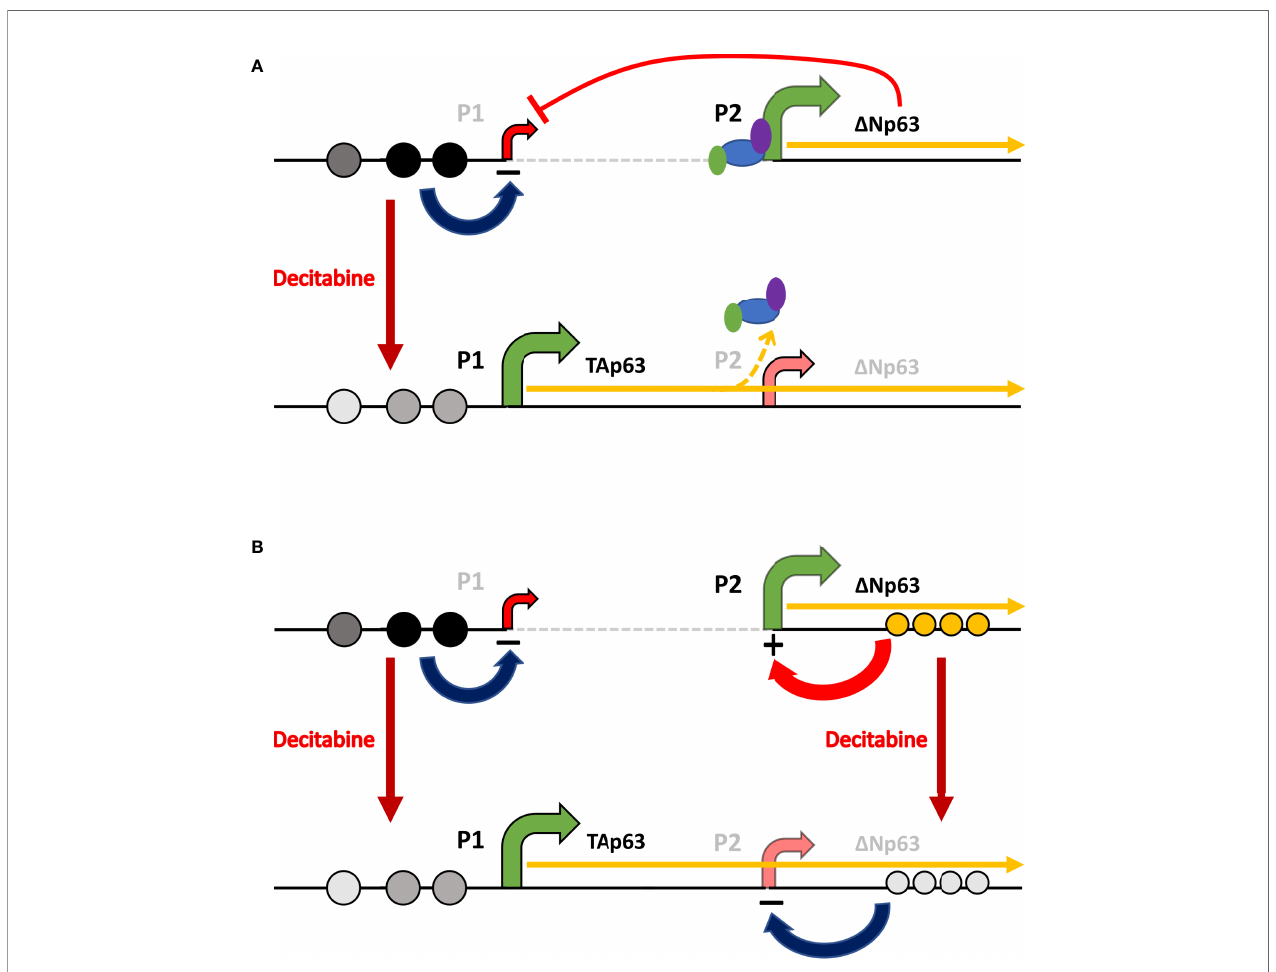
FIGURE 10 | Schematic of the potential mechanisms involved in reciprocal regulation of TAp63 and D Np63. (A) In squamous cells, where D Np63 is highly expressed from the P2 promoter, methylation of CpG sites (dark gray or black circles) at P1 inhibits TAP63 transcription and reduced methylation at these sites after decitabine (lighter gray circles) allows TAp63 production. As the TAP63 mRNA is elongated, it unavoidably transcribes through the P2 region thereby reducing transcription initiation at this site, perhaps by displacing transcription factors and RNA Polymerase II (colored ovals). (B) In addition, methylation/hydroxy-methylation within the gene body (orange circles) may activate D Np63 transcription, which is reduced after